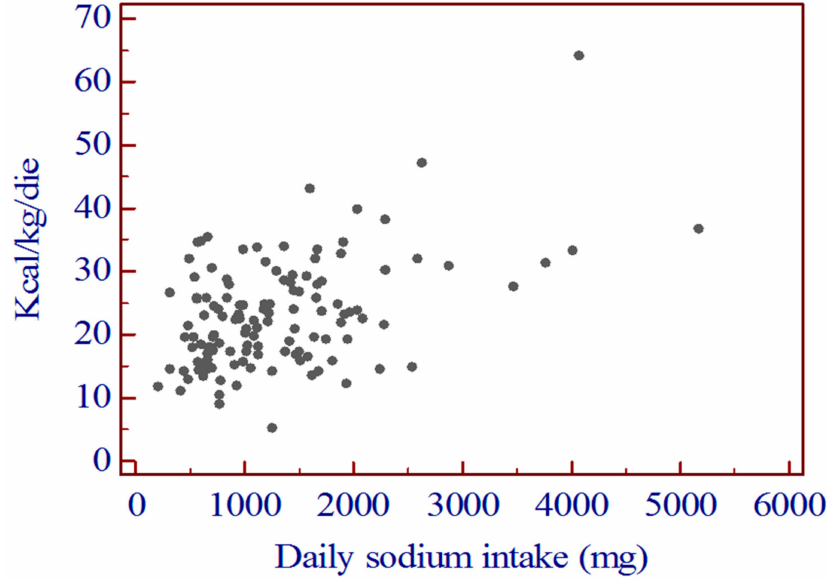
Figure 1. Correlation between daily sodium intake and daily calorie intake. r = 0.474 [0.327–0.599]; p <